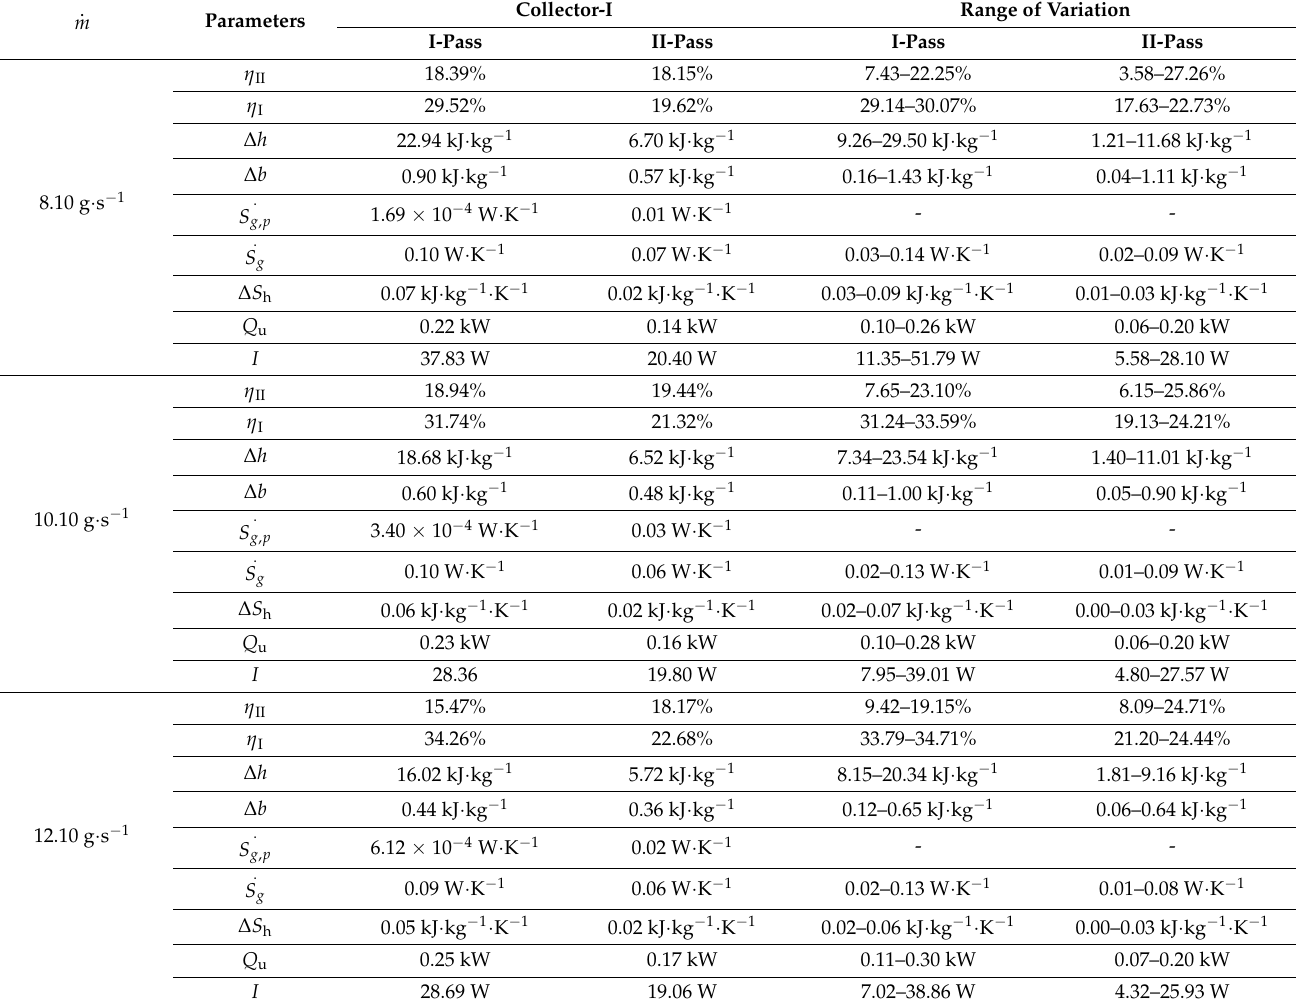
Table 5. Thermodynamic parameters related to the air flowing across the parallel duct of Collector-I.